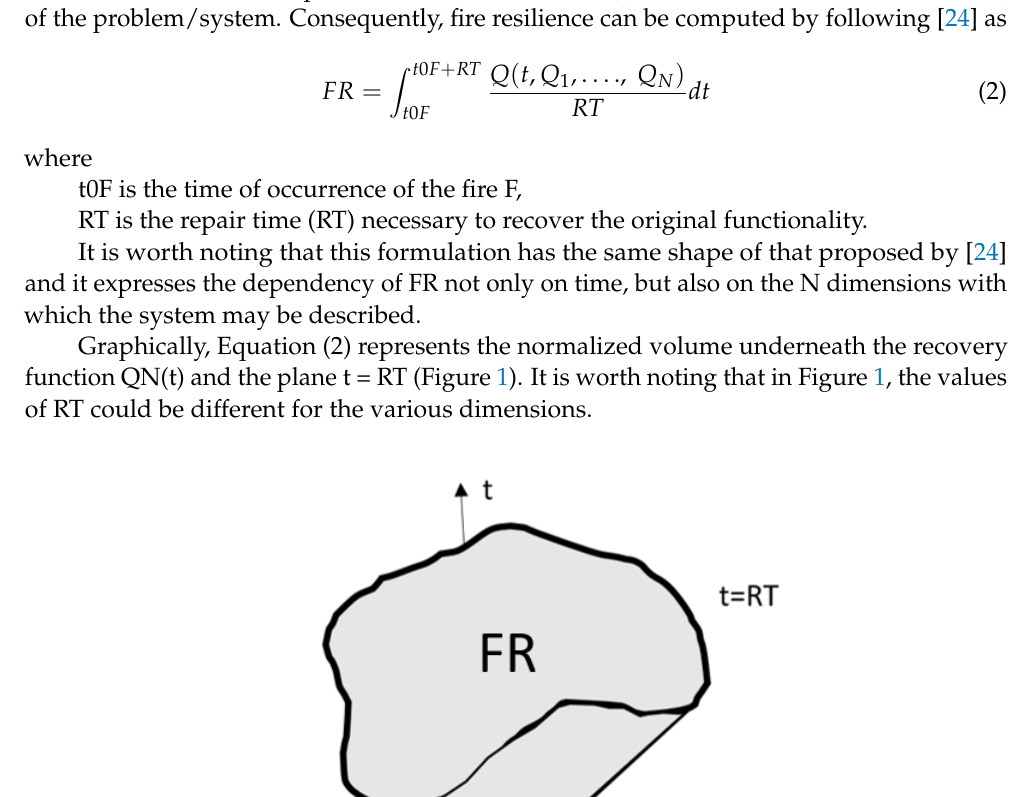
Figure 2. Contour lines of the functionality Q N (t). 4. The Role of Interdependencies on Fire Resilience As introduced, for fire hazards, the role of interdependencies is fundamental to con- sider the simultaneous impacts on systems. Interdependencies may be defined as the mu- tual interactions between several systems (i.e., energy, transportation, communication and water networks) that may be affected by the same event [33], in this case the fire. Interdependencies may cause significant consequences and thus the assessment of FR may be severely underestimated when they are neglected [51–55]. In particular, Ref. [51] proposed an object-oriented approach for generalized network-system analysis in order to model interdependent infrastructures. Ouyang et al. [52] suggested to assess the resili- ence of interdependent infrastructure systems by focusing on joint restoration modeling and analysis. Another interesting approach considered the community resilience-driven restoration model for interdependent infrastructure networks [53]. Urban interdepend- ency under earthquakes was studied in [54], which developed a methodology to quantify